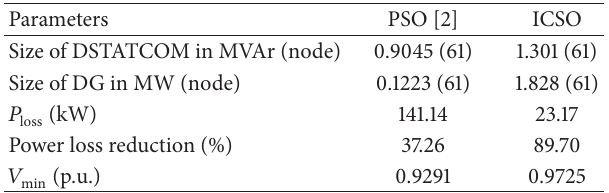
Table 5: Comparison